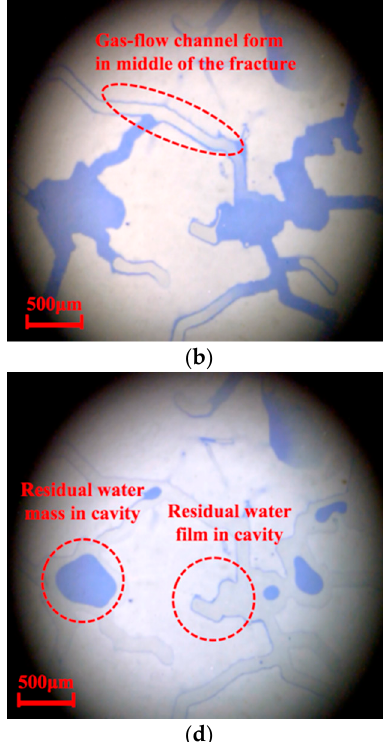
Figure 11. Gas-drive-water process of the cavity-type micromodel: ( a ) Initial stage; ( b ) Second stage; ( c ) Third stage; ( d ) Final stage.